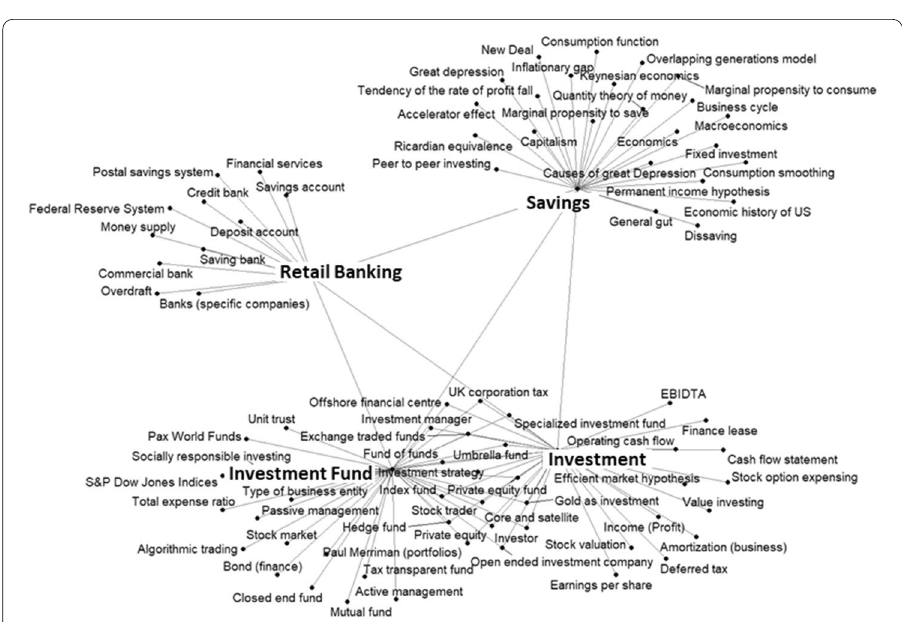
Fig. 1 Knowledge map of the four concepts: investment, investment funds, saving, and retail